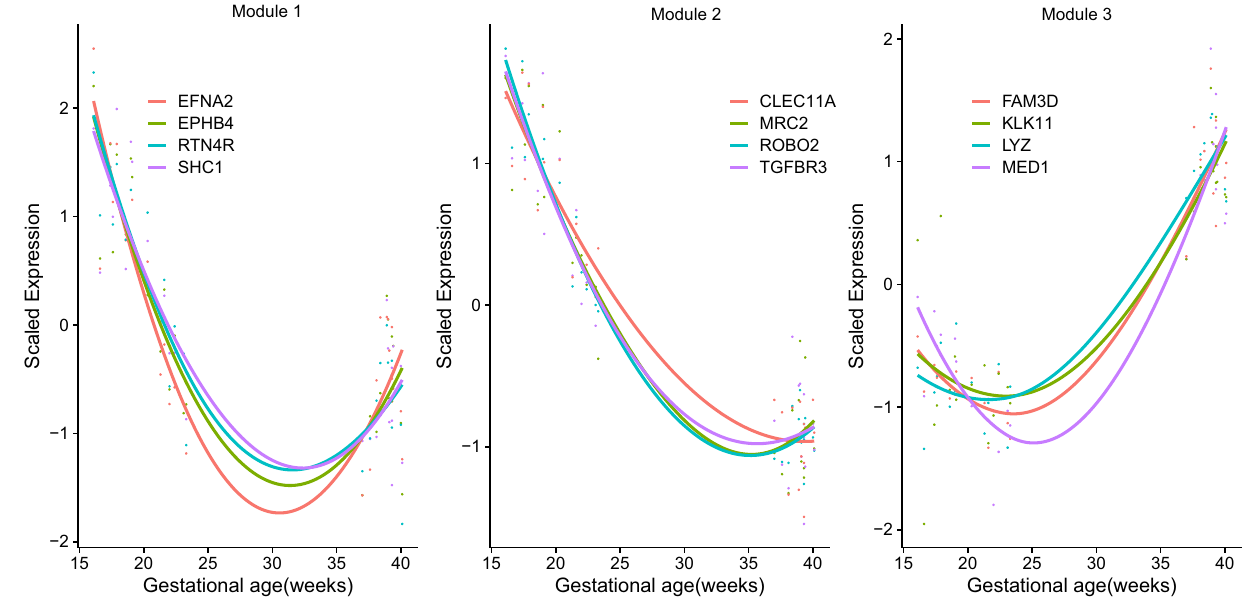
Figure 5. Clustering of amniotic fluid protein profiles during gestation. The figure shows locally estimated scatterplot smoothing (LOESS) regression plots (created in R 115 ) of gestational age-dependent abundance profiles of four intra-modular hub proteins in the three modules identified by weighted correlation network analysis